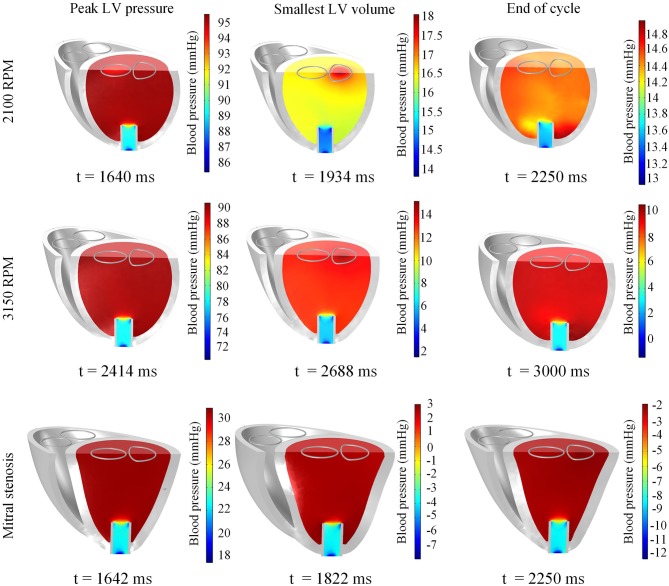
Snapshots of the biventricular model with LVAD depicting the LV blood pressure distribution at the times of peak LV pressure, smallest LV volume, and end-diastole. The snapshots are taken at the third cycle of stable 2,100 RPM pump speed (Top), fourth cycle following speed increment to 3,150 RPM (Middle), and third cycle of mitral stenosis (Bottom).